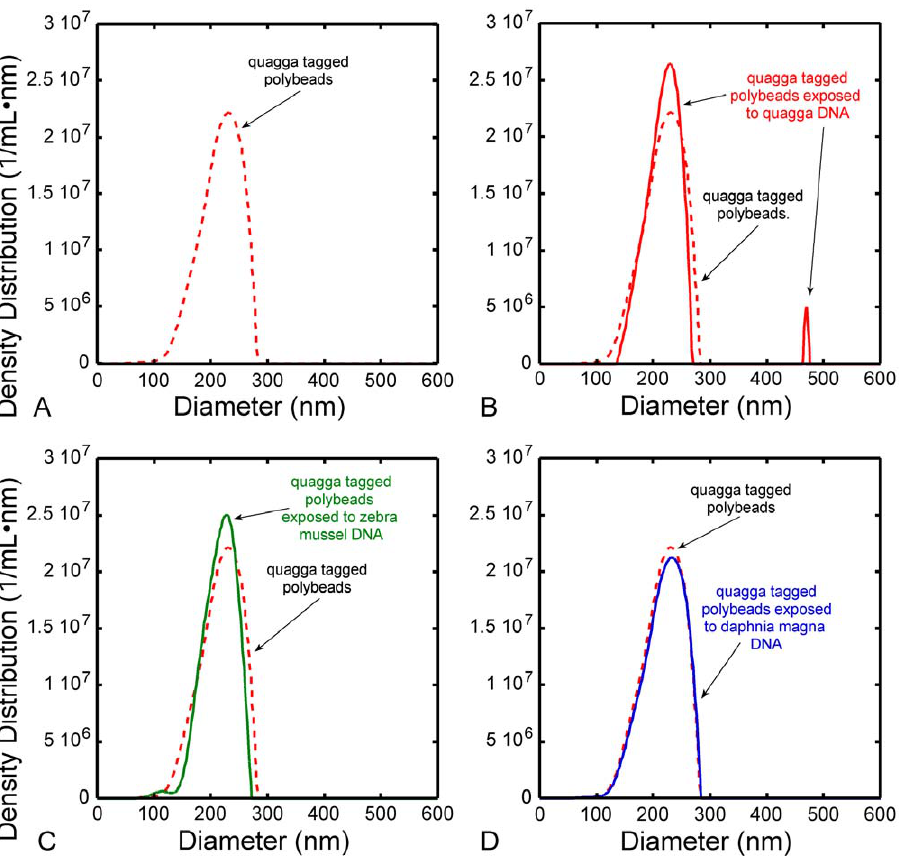
Figure 4. DNA detection using LTS. In A, B, C, and D the dashed red curve is the LTS particle size distribution of beads functionalized with quagga mussel tags. In B the solid red curve is the LTS particle size distribution obtained after quagga functionalized beads were exposed to denatured quagga mussel DNA where target DNA hybridization is indicated by the peak at 468 nm. In C and D the solid green and solid blue curves are the particle size distributions after quagga functionalized beads were exposed to denatured non-target DNA, zebra mussel and cladoceran respectively, where the absence of particles at larger sizes indicates a null response to non-target DNA. required for DNA detection. The reduction or elimination of a requisite PCR step has the potential to make LTS a powerful new addition to the DNA detection arsenal.